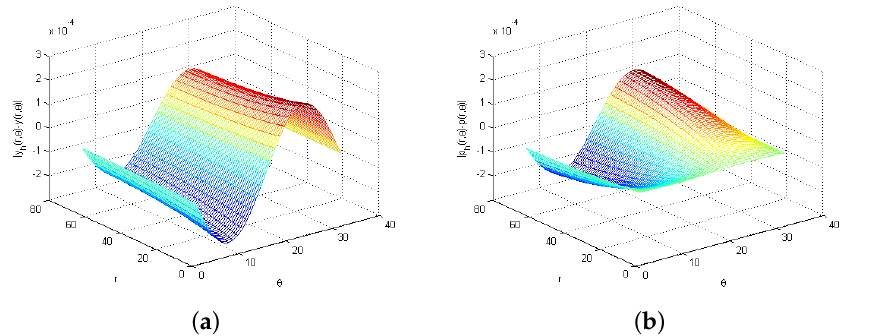
( a ) and exact solution p ( b ) with N = 64. h